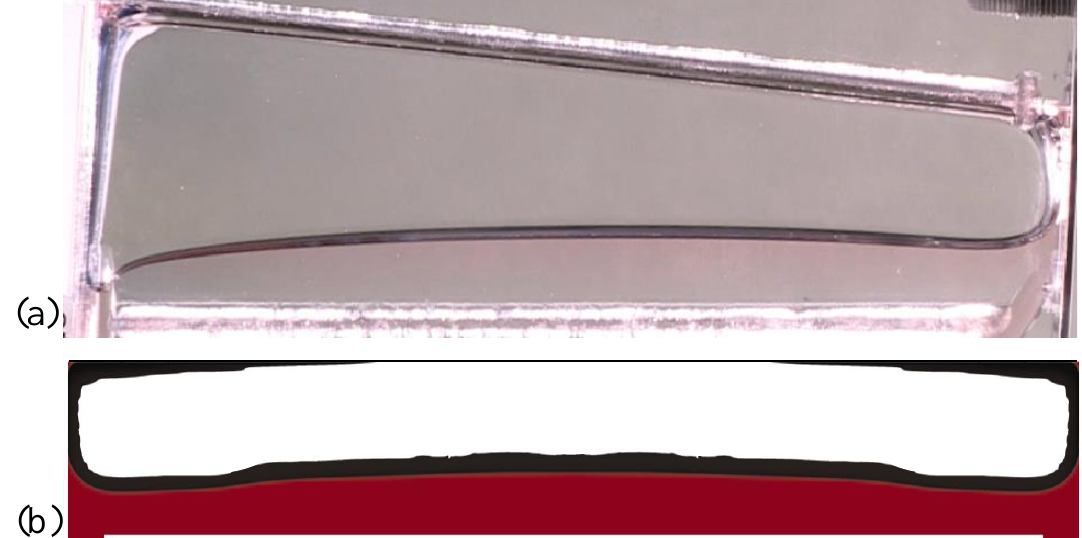
Figure 10. Profile view of the ICF-1 Tapered Section filled with liquid (red) at t = 10 s ( a ) during experiment and ( b ) simulation, where gray implies interfacial volume fraction α =